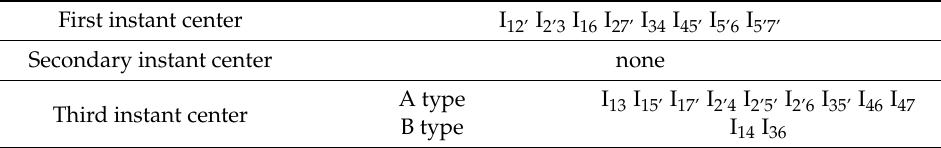
Table 6. Instant centers of six-bar planar linkage with virtual links. Table 7. Instant centers of six-bar planar linkage with Criterions 1 and 2. First and identified